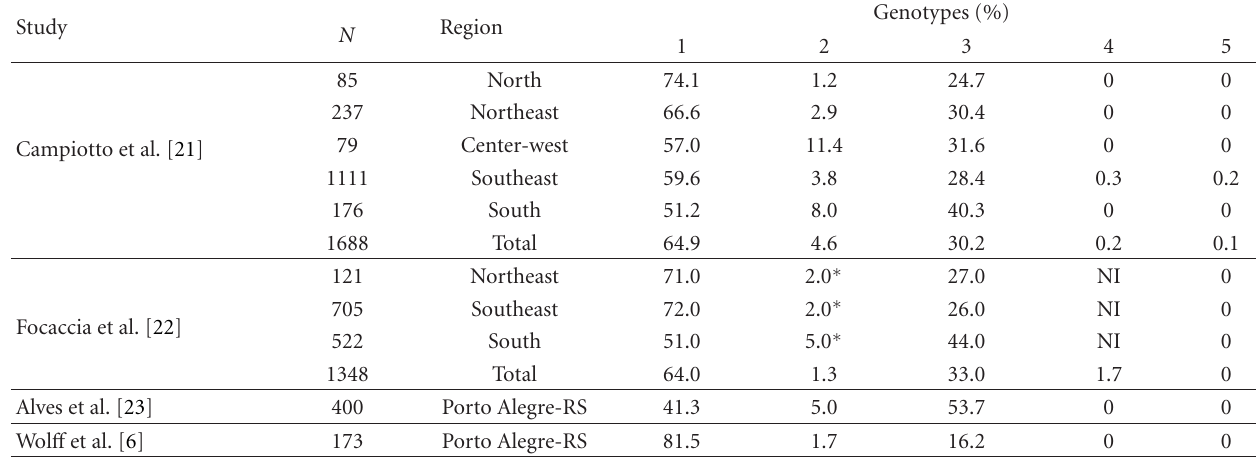
Table 4: Proportional HCV genotype distribution according to Brazilian